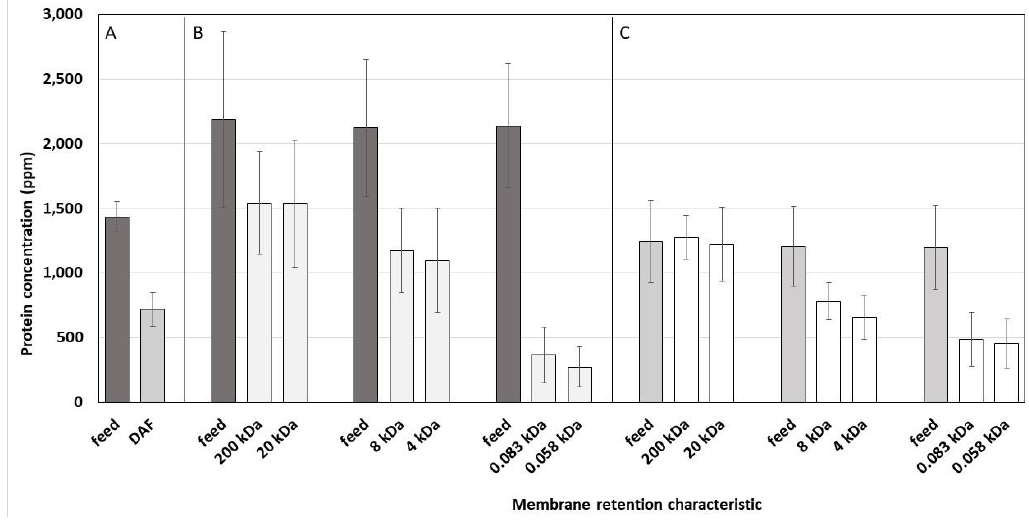
Figure 11. Protein concentration in the feed and the output/permeate of different treatments: A—DAF; B—membrane filtration; C—post-DAF membrane filtration.